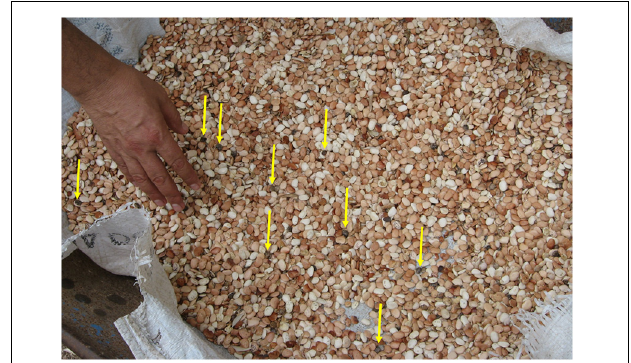
FIGURE 8 | Seeds of Lima bean with wild characteristics collected in a barn from Quintana Roo, Mexico. Yellow arrows point to these